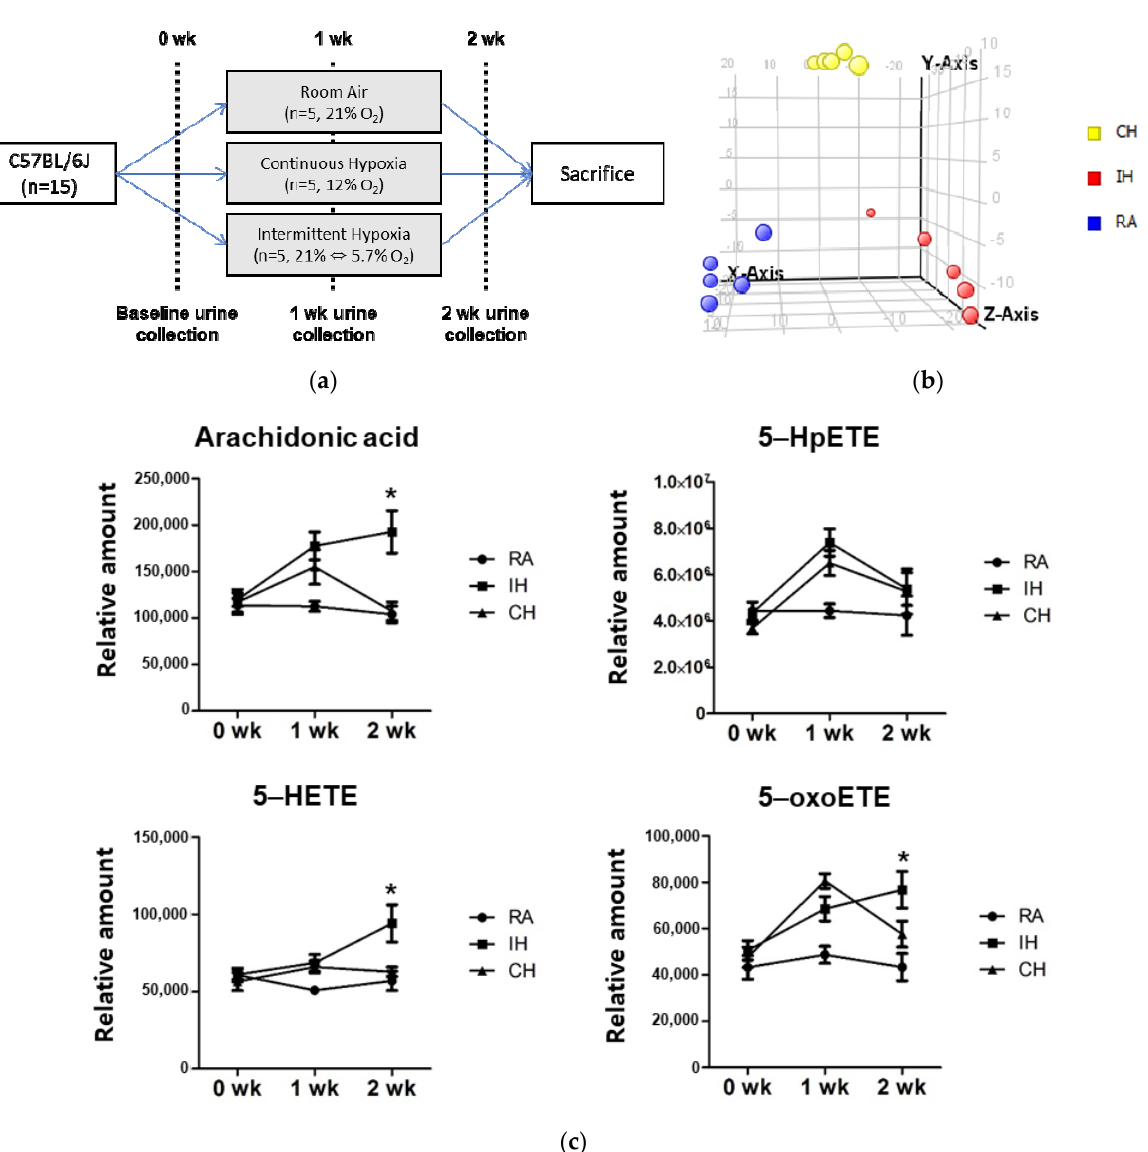
Figure 5. Changes of urine metabolites induced by hypoxic stimulus in a murine model. ( a ) The schema of the urine collection form the mice after exposure of room air (RA), continuous hypoxia (CH, 12% O 2 ), or intermittent hypoxia (IH, alternating period of 21% and 5.7% O 2 ) for 2 wks). ( b ) Results of the partial least squares discriminant analysis of urine specimens from the mice, which were exposed to three different oxygen surroundings. ( c ) Change of arachidonic acid and its derivatives 5 ‐ HpETE, 5 ‐ HETE and 5 ‐ oxoETE in mice urine at baseline, 1 and 2 wks after the treatment. * p values < 0.05.